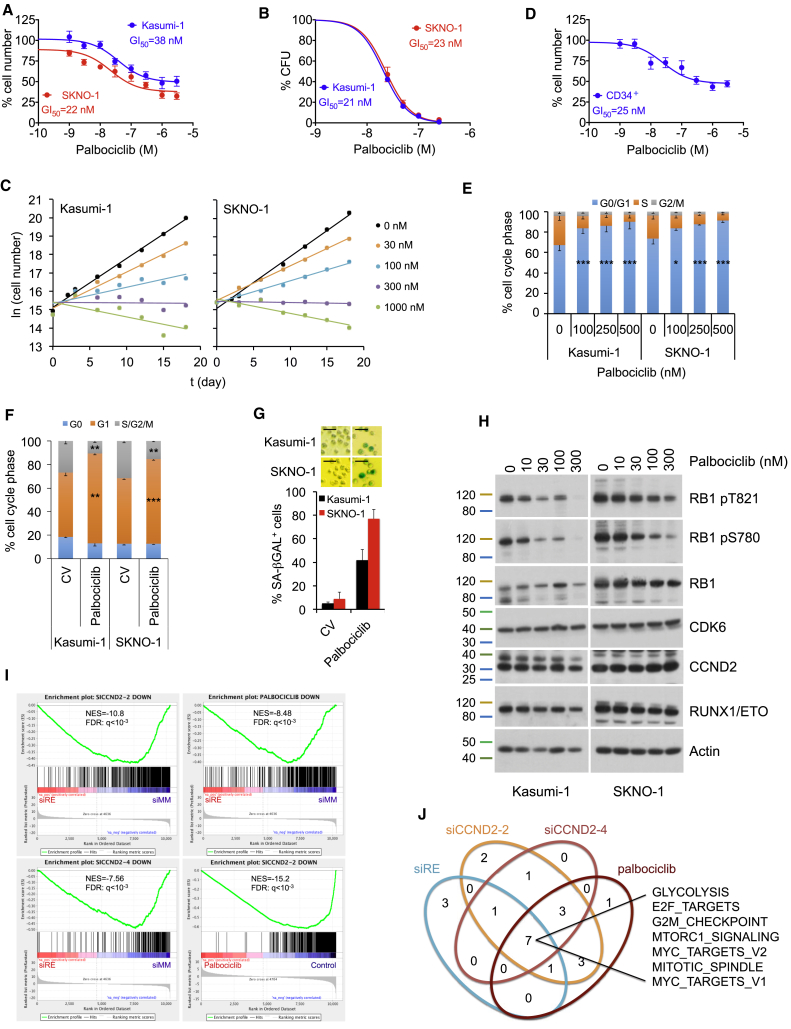
The CDK4/6 Inhibitor Palbociclib Inhibits Growth of RUNX1/ETO-Expressing Leukemic Cells(A) Dose-response curve for proliferation of SKNO-1 and Kasumi-1 cells treated for 72 hr with the indicated palbociclib concentrations. Mean ± SD; n = 6.(B) Dose-response curve for inhibition of colony formation by palbociclib. Colonies formed in presence of palbociclib were counted 14 days after seeding. Mean ± SD; n = 3.(C) Growth curves of t(8;21) cell lines during long-term treatment with palbociclib. Mean ± SD; n = 3.(D) Dose-response curve for proliferation of CD34+ cord blood cells expressing truncated RUNX1/ETO9a treated with palbociclib for 72 hr. Mean ± SD; n = 3.(E) Cell cycle distribution of Kasumi-1 and SKNO-1 cells after 72 hr treatment with the indicated palbociclib doses. Mean ± SD; n = 3. ∗∗∗p < 0.001; ∗p < 0.05 compared with no palbociclib (CV).(F) Cell cycle distribution as indicated by Pyronin Y and Hoechst33342 staining of Kasumi-1 and SKNO-1 cells with and without 50 nM palbociclib for 24 hr. ∗∗∗p < 0.001; ∗∗p < 0.01 compared with no palbociclib (CV).(G) Impact of CDK4/6 inhibition on senescence in Kasumi-1 and SKNO-1 cells as indicated by staining for SA-βGAL. Top panels, stained cells after 7 days with 50 nM palbociclib; bottom panel, quantitation of SA-βGAL-positive cell numbers. Mean ± SD; n = 5 technical replicates. Scale bar, 50 μm.(H) Immunoblots showing dose-dependent impact of 72 hr palbociclib treatment on indicated protein levels in Kasumi-1 and SKNO-1 cells.(I) GSEA for correlation between palbociclib, RUNX1/ETO, and CCND2 knockdown signatures derived from RNA-seq. NES, normalized enrichment score.(J) Hallmarks of cancer pathways shared between palbociclib treatment, CCND2, and RUNX1/ETO knockdown. Enriched pathways were identified by GSEA.See also Figure S6.